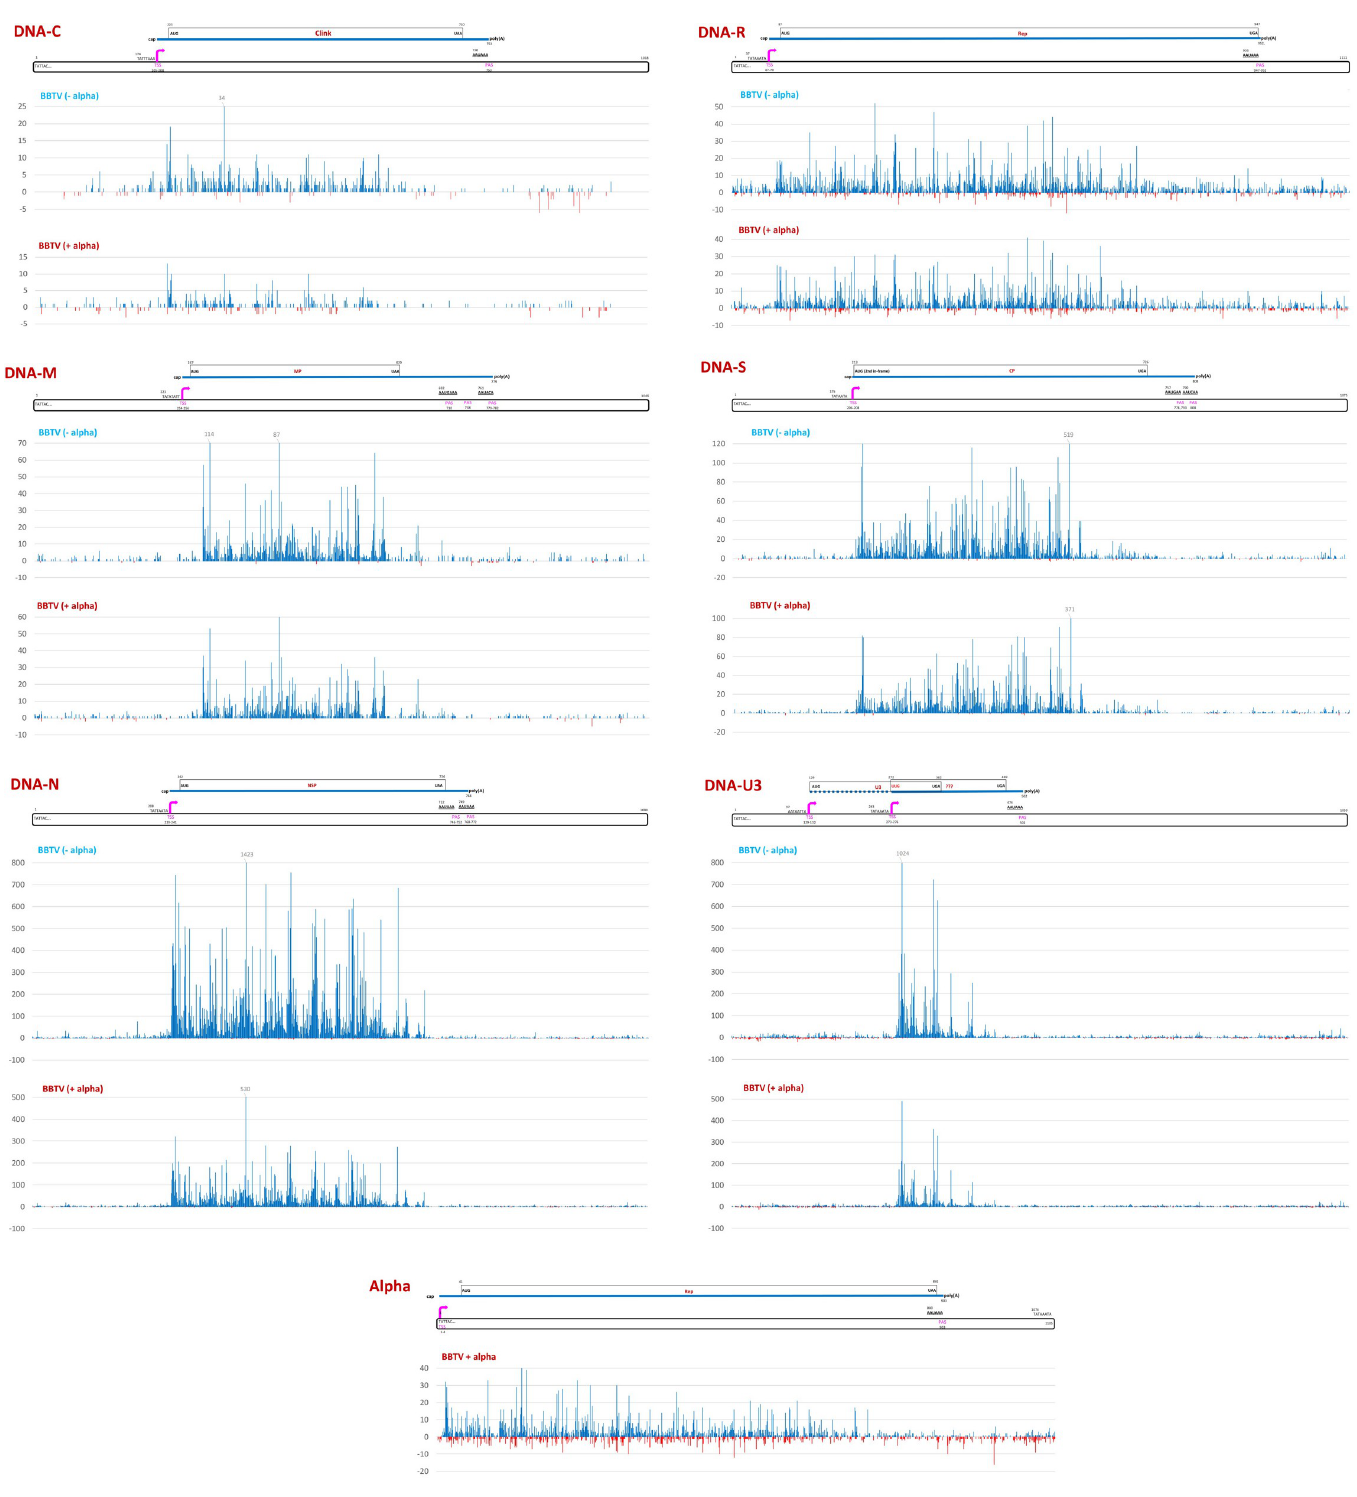
Fig 6. Single nucleotide resolution maps of Illumina mRNA-seq reads representing poly(A)-enriched viral transcripts from BBTV-infected Cavendish banana plants with or without DRC alphasatellite. For each of the two conditions, i.e. without (BBTV-alpha) and with (BBTV+alpha) alphasatellite, Illumina 75 nt paired-end reads of the three biological replicates (leaf tissues of three plants) were combined and mapped simultaneously onto the reference sequences of six BBTV components (-/+ alphasatellite). Histograms plot the numbers of viral 75 nt reads at each nucleotide position of the 1018-to-1111 nt BBTV genome components (DNAs C, M, N, R, S,